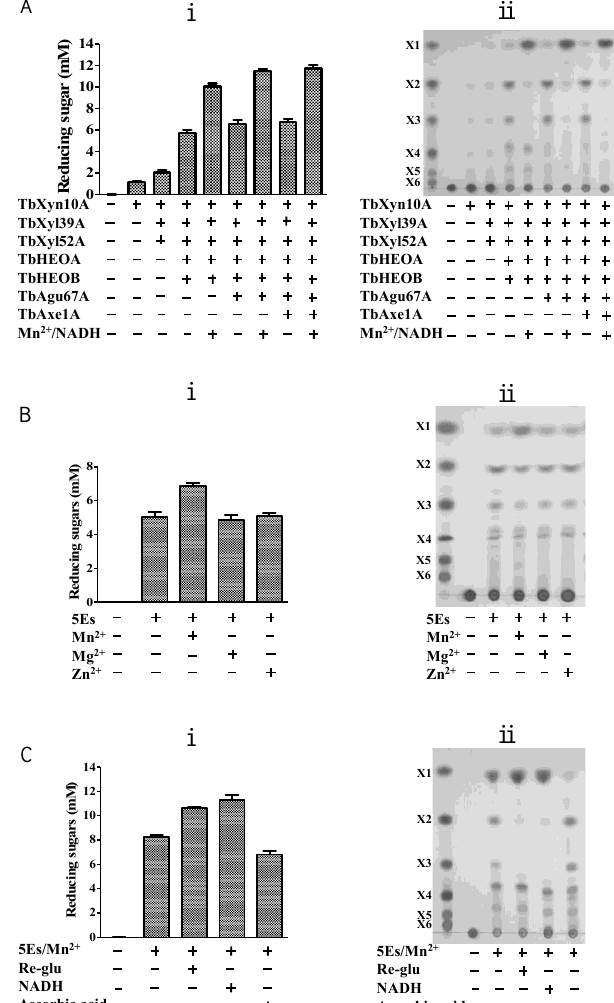
Figure 6. Effect of different divalent metal ions and redox-active cofactors on the hemicellulase- enhancing activities of two oxidoreductase-like polypeptides, TbHEOA and TbHEOB, during hy- drolysis of BWX by hemicellulases (TbXyn10A, TbXyl39A, TbXyl52A, TbAgu67A, and TbAxe1A). ( A ) Analysis of the effect of different divalent metal ions on hydrolysis of BWX by 5Es (TbXyn10A, TbXyl39A, TbXyl52A, TbHEOA, and TbHEOB). Five mg/mL of BWX was incubated with the five- enzyme mixture (10 nM TbXyn10A, 10 nM TbXyl39A, 5 nM TbXyl52A, 50 nM TbHEOA, and 50 nM TbHEOB) at 60 °C in a citrate buffer (pH 5.5) for 16 h, in the absence or presence of different metal ions (1.0 mM Mn 2+ , 1.0 mM Mg 2+ , or 1.0 mM Zn 2+ , respectively). ( B ) Analysis of the effect of different redox-active cofactors on hydrolysis of BWX by 5Es. The experiment was carried out by incubating 5 mg/mL of BWX with the five enzymes mixture (10 nM TbXyn10A, 10 nM TbXyl39A, 5 nM TbXyl52A, 100 nM TbHEOA, and 100 nM TbHEOB) at 60 ◦ C in a citrate buffer (pH 5.5) with 1 mM Mn 2+ for 16 h in the absence or presence of different cofactors (1 mM NADH, 1 mM Ascorbic acid, and 0.5 mM Re-glu, respectively). ( C ) Analysis of the effect of Mn 2+ and NADH on hydrolysis of BWX by different combinations of the seven enzymes (TbXyn10A, TbXyl39A, TbXyl52A, TbHEOA, TbHEOB, TbAgu67A, and TbAxe1A) encoded in the T. bryantii hemicellulase gene cluster. Five mg/mL of BWX was incubated with different combinations of the seven enzymes (10 nM TbXyn10A, 10 nM TbXyl39A, 5 nM TbXyl52A, 100 nM TbAgu67A, 100 nM TbAxe1A, 100 nM TbHEOA, and 100 nM TbHEOB) at 60 ◦ C in a citrate buffer (pH 5.5) for 16 h, in the presence or absence of 1 mM of NADH and 1 mM of MnSO 4 . The end products of hydrolysis were analyzed through the reducing sugar assay (i) and TLC (ii). 5Es is defined as the five-enzyme mixture (TbXyn10A, TbXyl39A, TbXyl52A, TbHEOA, and TbHEOB). Other abbreviations were, X1: xylose; X2: xylobiose; X3: xylotriose; X4: xylotetraose; X5: xylopentaose; X6: xylohexaose; Re-glu: reduced